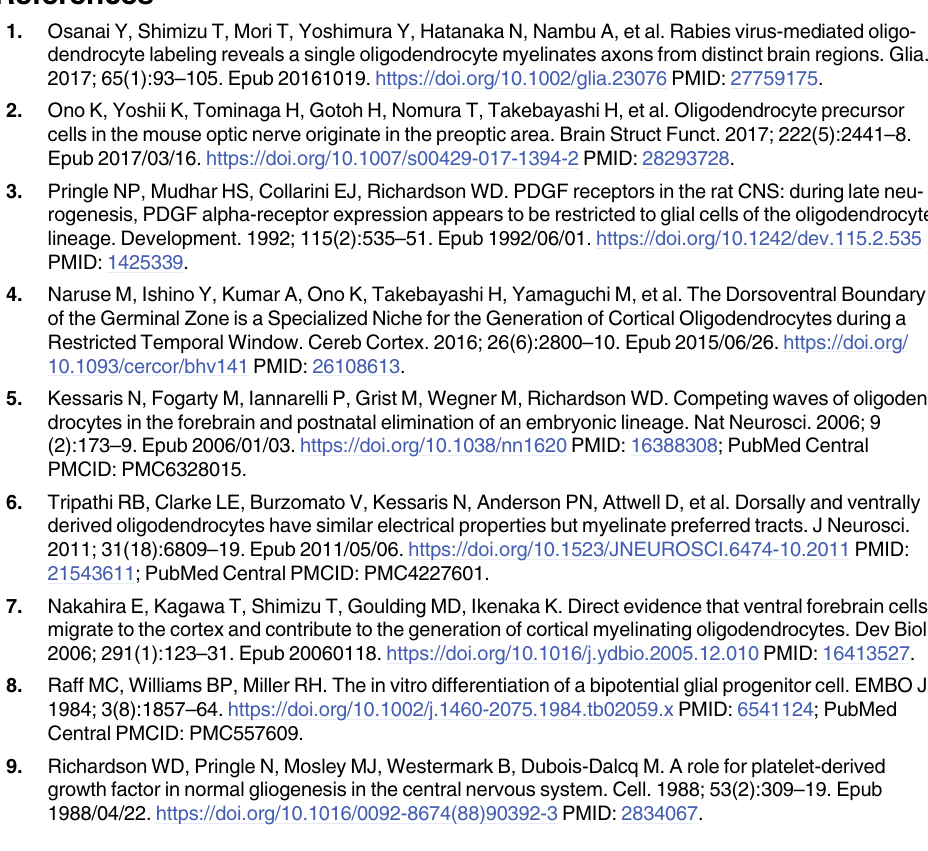
Fig 4F. Cytoplasm is indicated by white